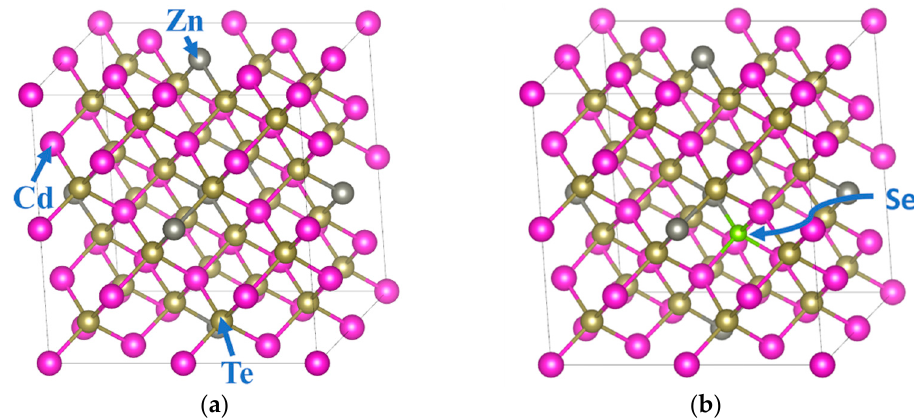
Figure 2. Representation of 64 atom primitive supercell used for the DFT calculations for single crystals of ( a ) defect free CZT; ( b ) CZTS showing one Te atom replaced by a Se atom in the CZT zinc-blend matrix.